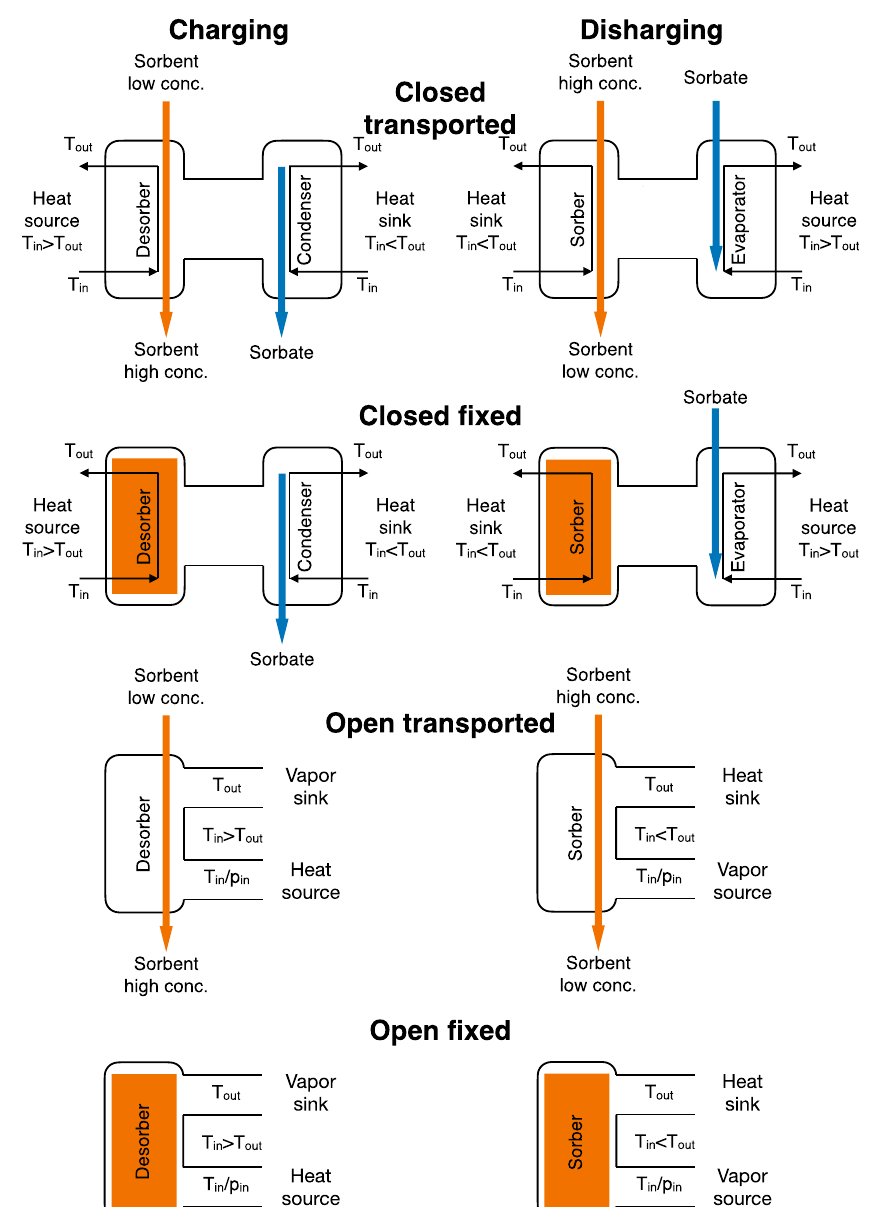
Figure 2. Illustrations of the four processes in charging and discharging. Indicated are the relevant heat source and sink temperatures and vapor pressures [12].